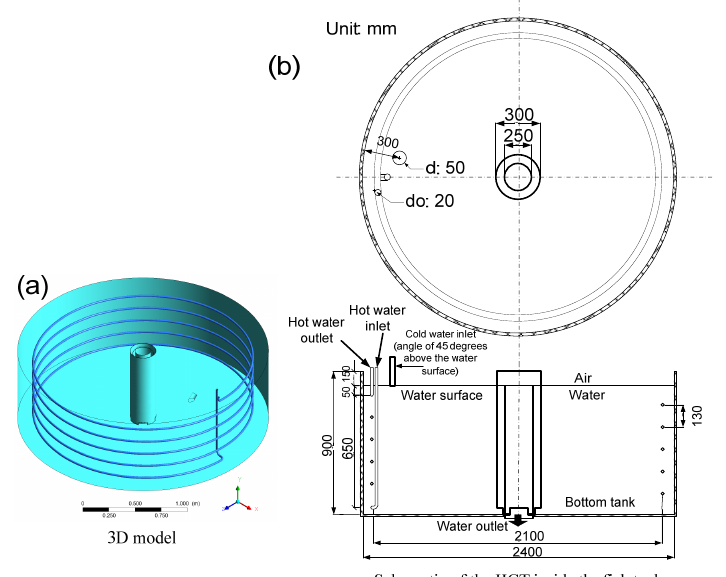
Figure 1. ( a ) Simulation model and ( b ) schematic of the helically coiled tube (HCT) inside the fish tank [15].